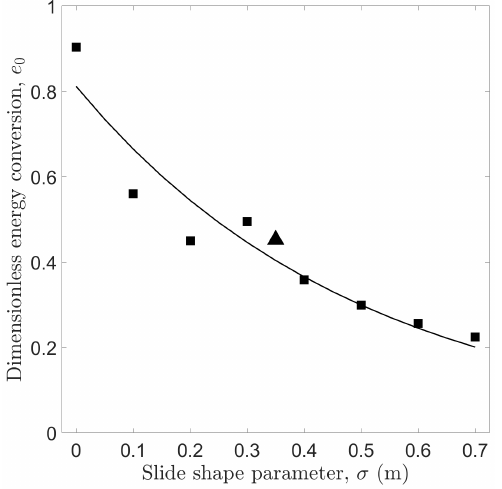
Figure 9. Energy conversion ratio, e 0 , verses slide shape parameter, σ . (cid:4) : model predictions. (cid:78) : result by the reference solid slide. Curve: exponential fitting by e 0 = c 1 exp ( c 2 σ )